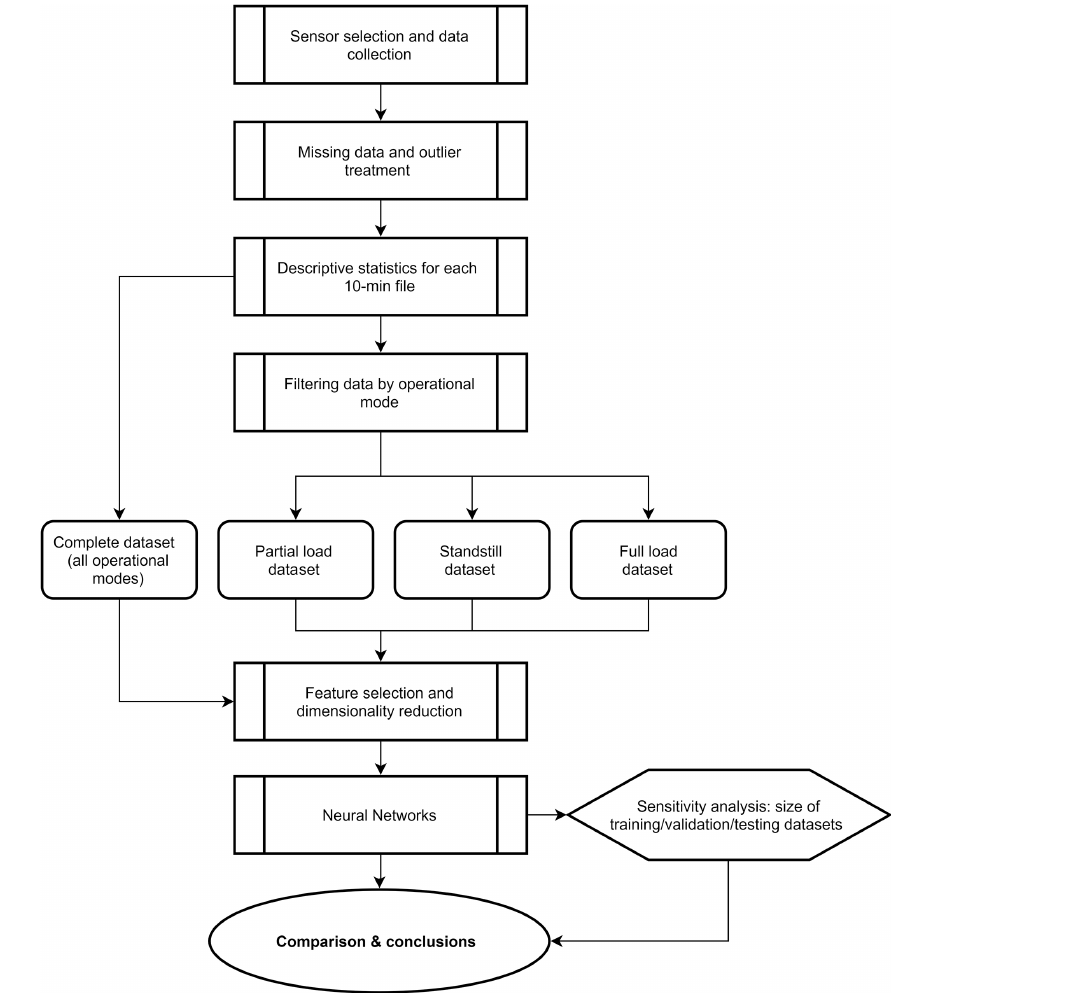
Figure 1. Main methodological